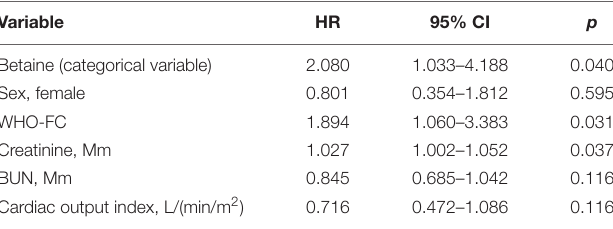
TABLE 2 | Multivariate Cox analysis of plasma betaine levels and clinical outcomes. Variable